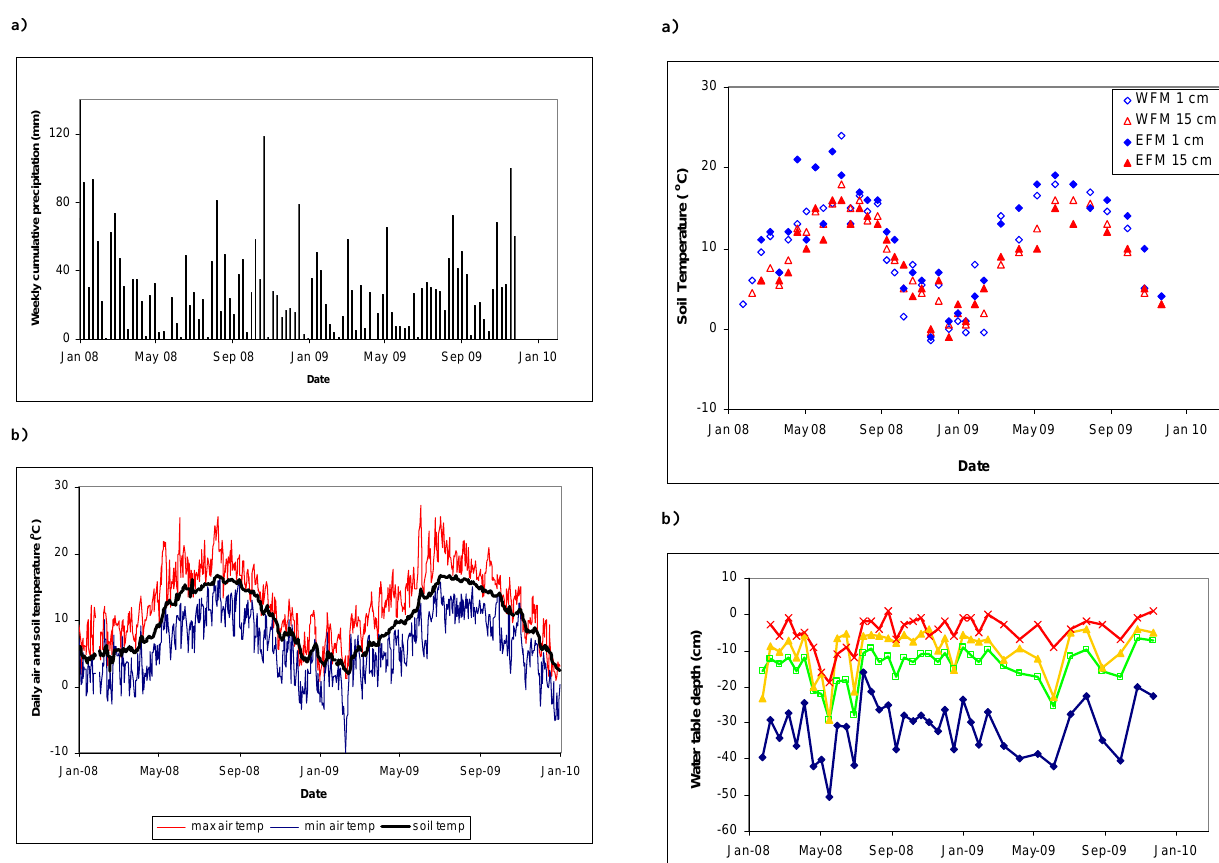
no clear seasonal pattern in the water table depth although maxima and minima, respectively, reflected high and low pe- riods of precipitation (Fig.